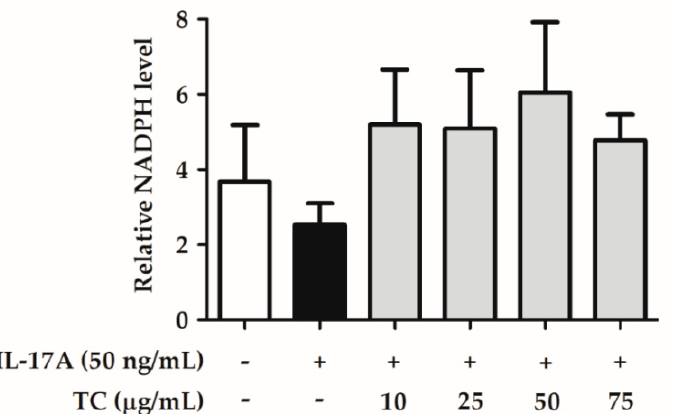
Figure 8. TC restores basal NADPH levels in IL-17A-treated human keratinocytes. TC could restore reduced NADPH levels upon IL-17A treatment in human keratinocytes.